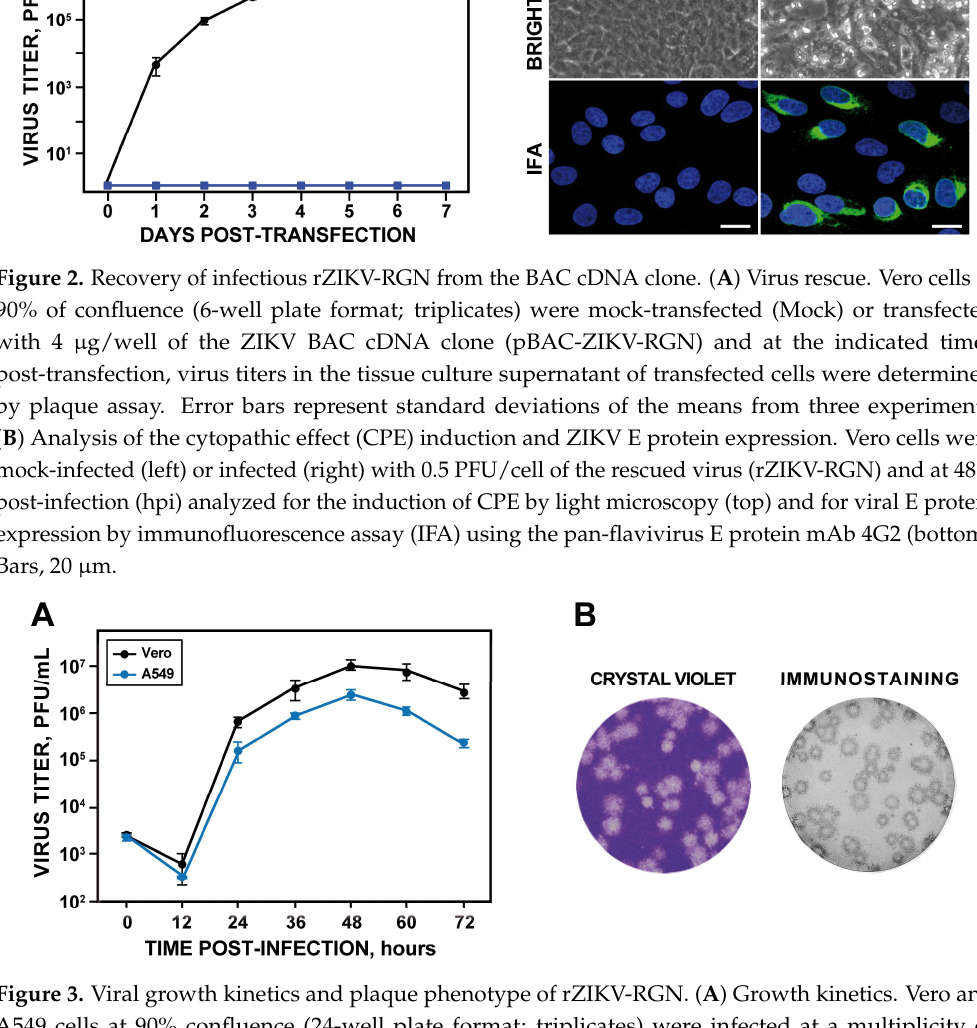
Figure 3. Viral growth kinetics and plaque phenotype of rZIKV-RGN. ( A ) Growth kinetics. Vero and A549 cells at 90% confluence (24-well plate format; triplicates) were infected at a multiplicity of infection (MOI) of 1 PFU/cell and at the indicated hpi, virus titers in the tissue culture supernatants were determined by plaque assay on Vero cells. Error bars represent standard deviations of the mean